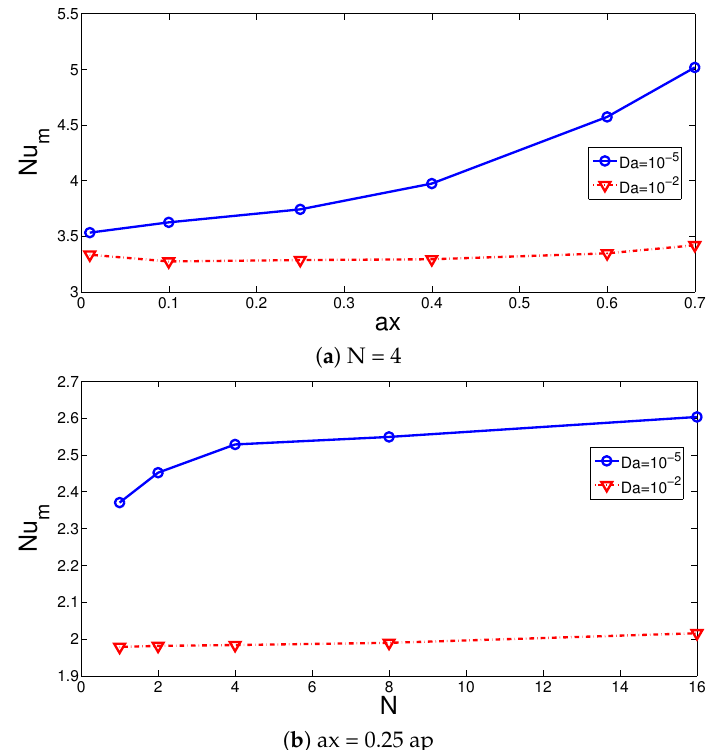
Figure 13. Corrugation amplitude ( a ) and wave number ( b ) on the average Nu variations (Re = 250, Rew = 1000, Ha = 7.5).